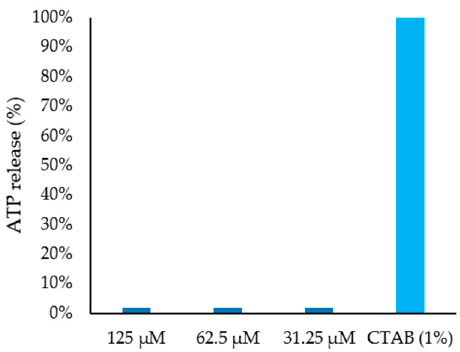
Figure 6. ATP release from S. aureus when treated with cholic acid derivative 7e with cetyltrimethylammonium bromide (CTAB) (1%) as the positive control.